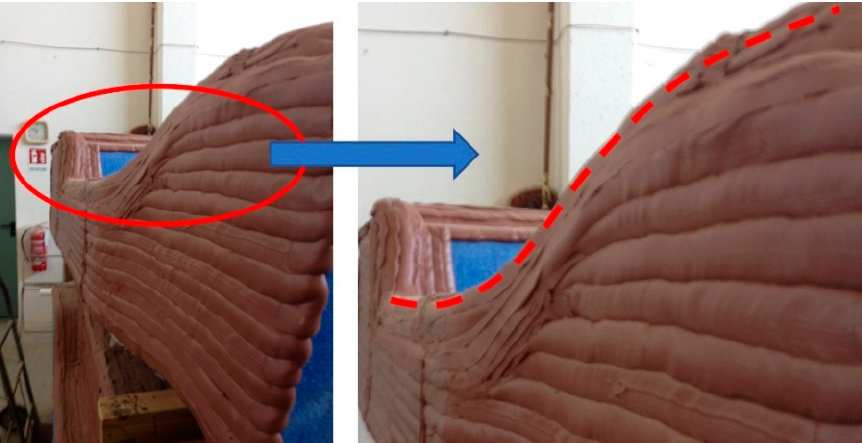
Figure 11. Modelling clay deposition along 3D paths over a large-scale mould for marine applications. On the right, a detailed view of the path followed by the extrusion head.